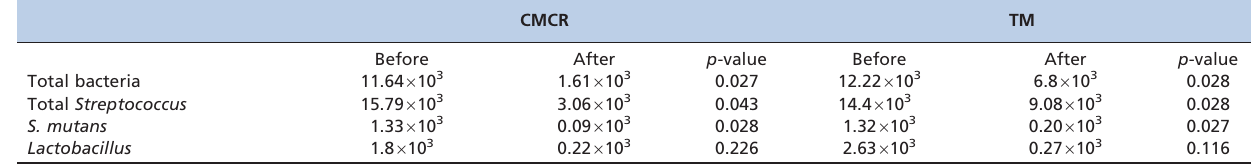
Table 2 - Mean number of colony-forming units in each group before and after caries removal. CMCR TM Before